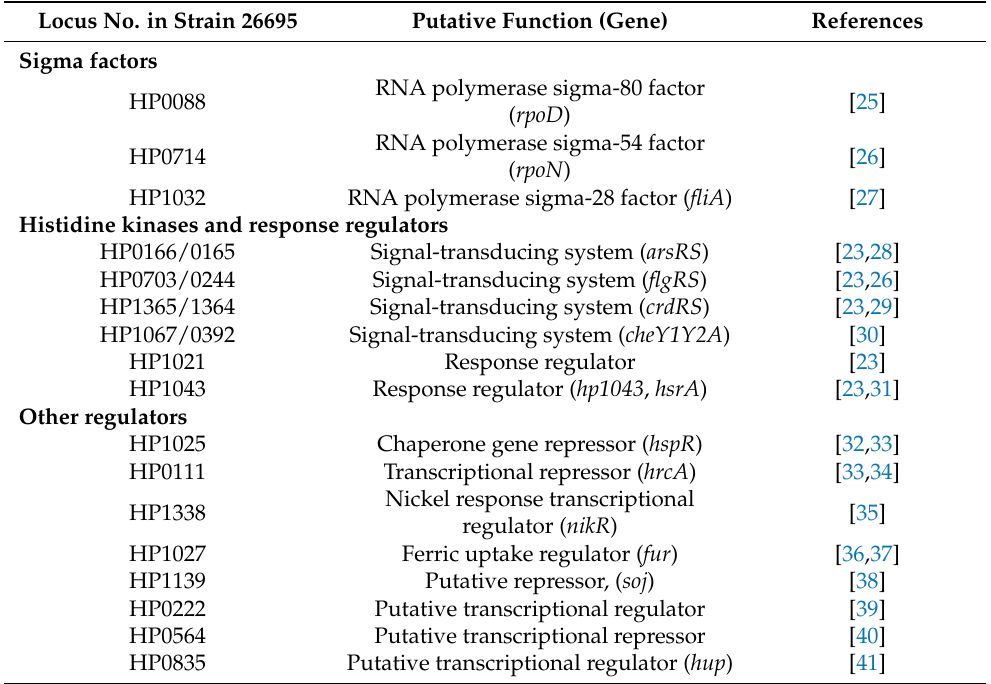
Table 1. Transcriptional regulators predicted in the H. pylori genome. Locus No. in Strain 26695 Putative Function